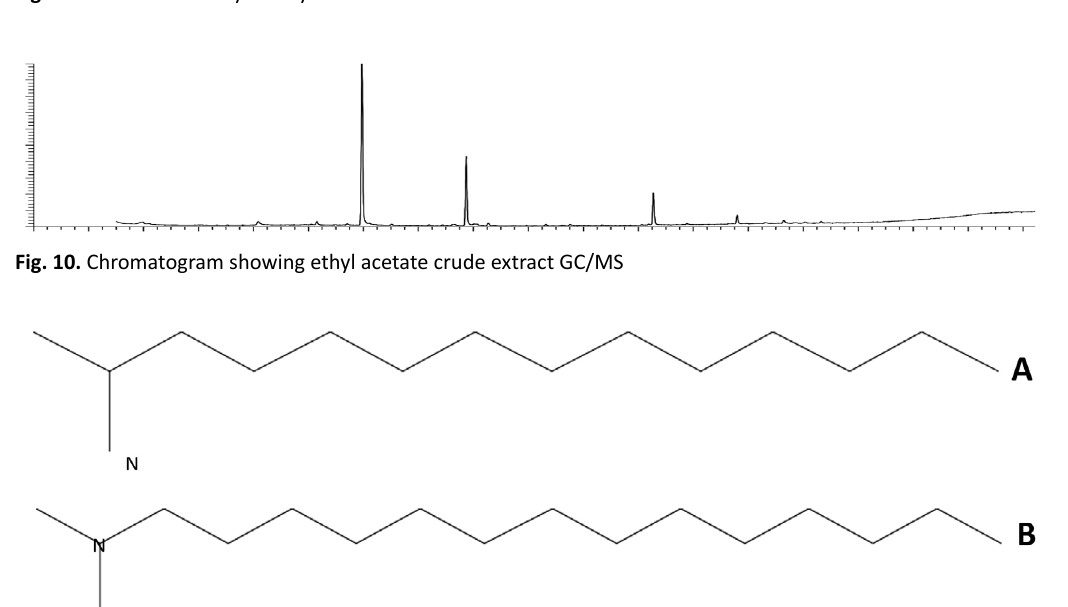
Fig. 9. Antioxidant activity of ethyl acetate crude extract.